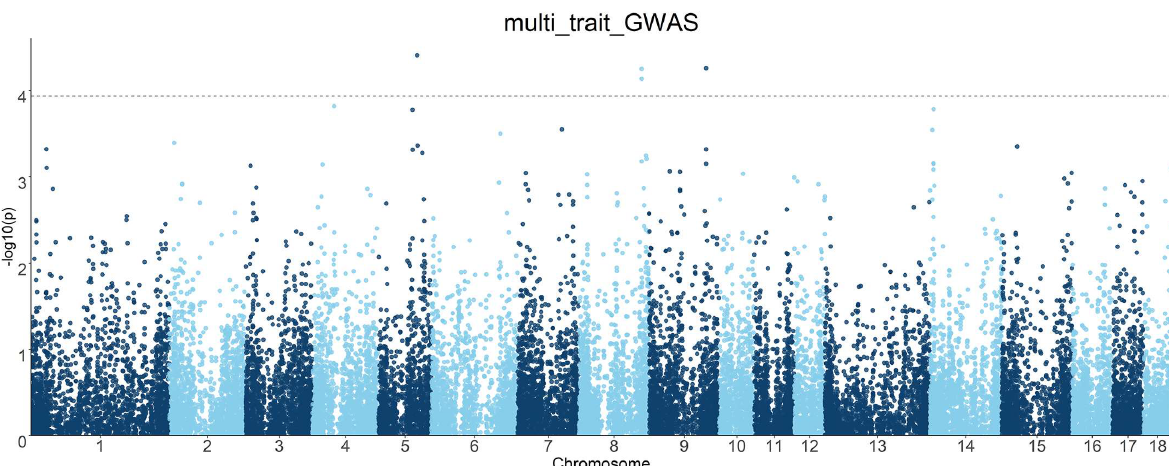
Figure 4. Manhattan plots of multi-trait GWAS results for six internal organ weight traits in the DLY population. The x -axis represents the chromosome, and the y -axis represents the − log10 ( p -value) value in the Manhattan plot of the GWAS. The dashed line indicates the FDR-corrected threshold.